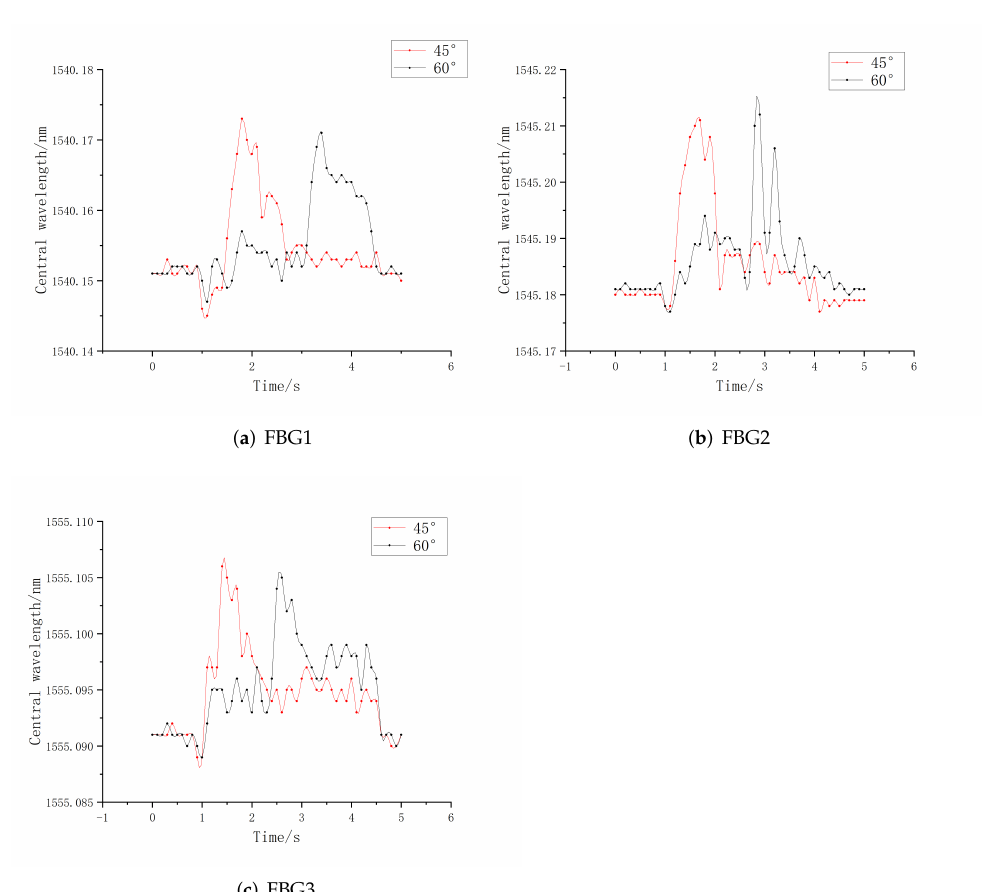
Figure 16. Wavelength relationship diagram for different